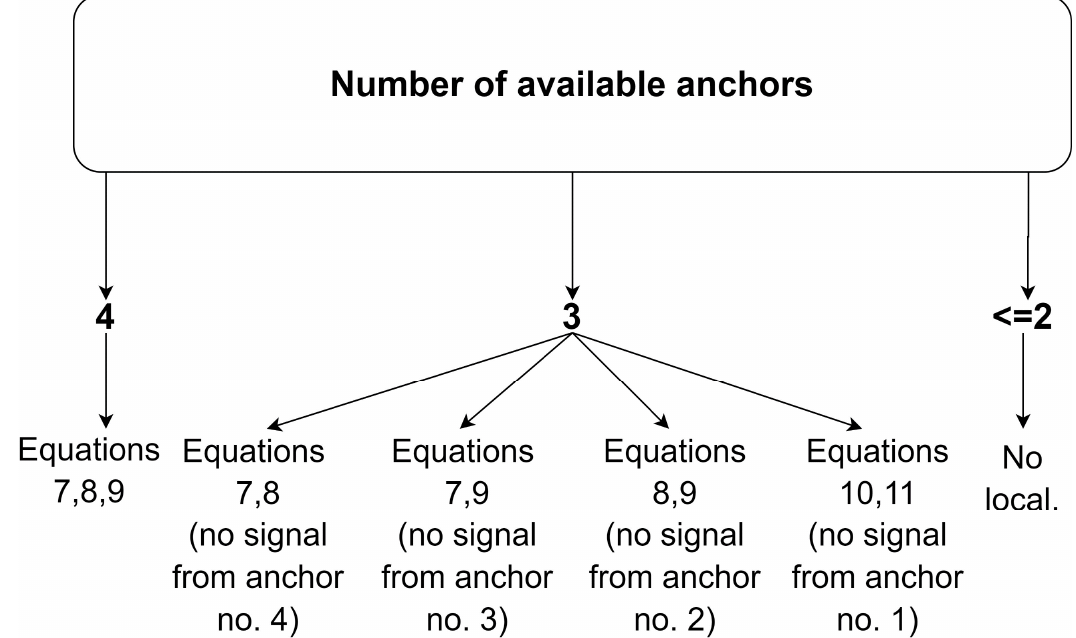
Figure 7. Conditional scheme of equation selection in the trilateration algorithm.